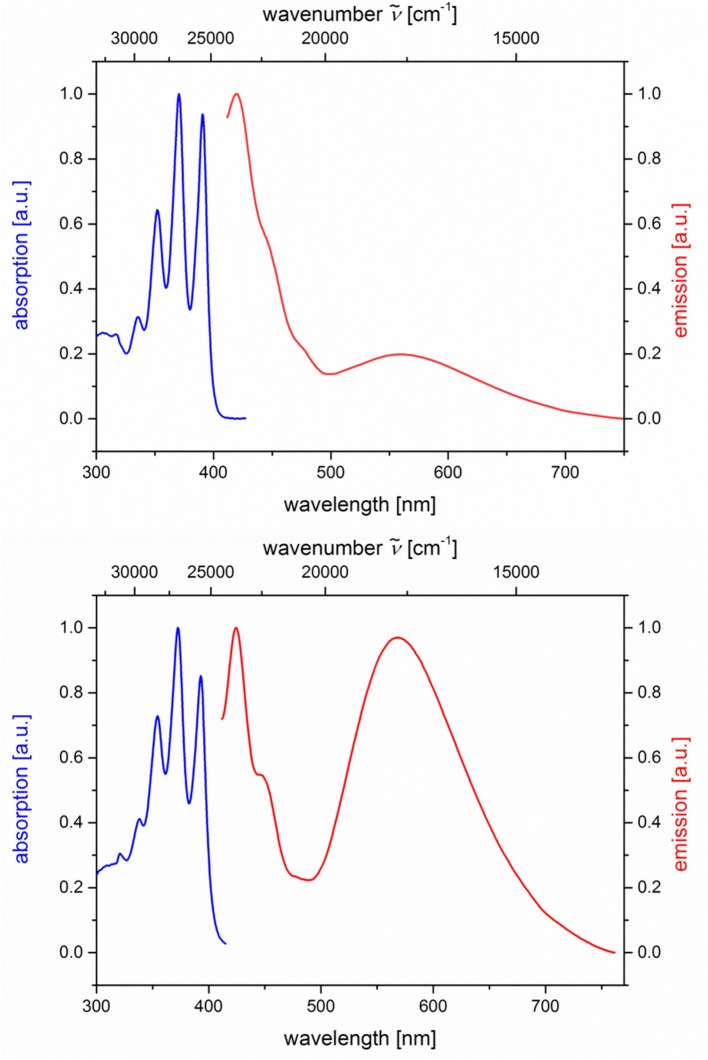
Normalized absorption (blue lines) and emission (red lines) spectra of compounds 5a (top) and 5b (bottom) (recorded in CH2Cl2 (chromasolv), T = 298 K, λexc = 391 nm).